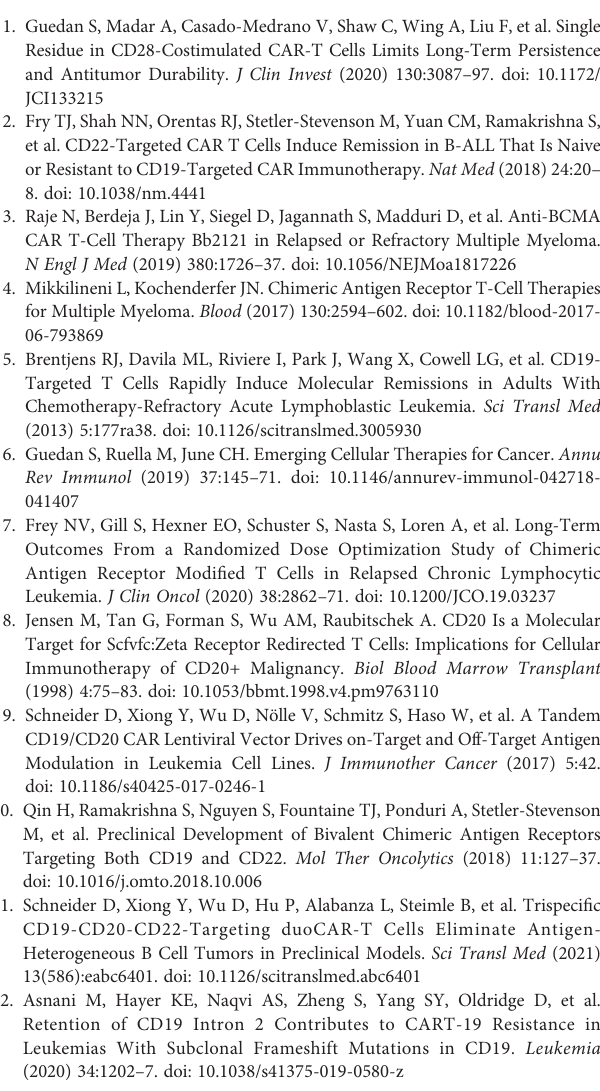
Supplementary Table 3 | A, 3B Summary of gene expression by MFI, based on fl owcytometry pro fi les,S3. Table3A )Effectorcells(NK92,UTD,CD22CAR-T)with or without bryostatin treatment (+Bryo) were analyzed for expression of Activating Ligands (orange blocks, column 1): MFI for NKG2D, DNAM1, NKp30, NKp44, NKp46, TRAIL, FasL; and for Inhibitory Ligands (blue blocks, column 1) KIR2DL1/ DS1, KIR3DL1/DS1, NKG2A; and for adhesion receptors (gray blocks, column 1) ICAM1, ICAM2, LFA1, CD56 are shown. Table 3B) NK ligands (column 3) interacting with Activating Receptors (column 2, orange blocks), Inhibitory Receptors (column 2, blue blocks), and adhesion receptor (gray block, column 1) are listed according to expression on leukemia cell line targets (NALM6, REH, Raji, K562) that have been untreated or treated (+bryo) with bryostatin. MFI for MIC-A/B, ULBP1, ULBP-2/5/6, ULNP3, NECTIN2, B7H6, BAG6, DR4, DR5, Fas, HLA-A,B, C, HLA-E, ICAM1, and ICAM2 are shown. MFI was calculated by (geometric mean of ligand fl uorescence – geometric mean of isotype fl uorescence). Supplementary Table 4 | (ST4) Total reads and reads exceeding threshold. Table (ST2_CutNTag_differential) describes methylation patterns (me2 and me3) of histone 3 (H3) modi fi cations at lysine 4 (K4). The fi rst of each pair of tabs reports all